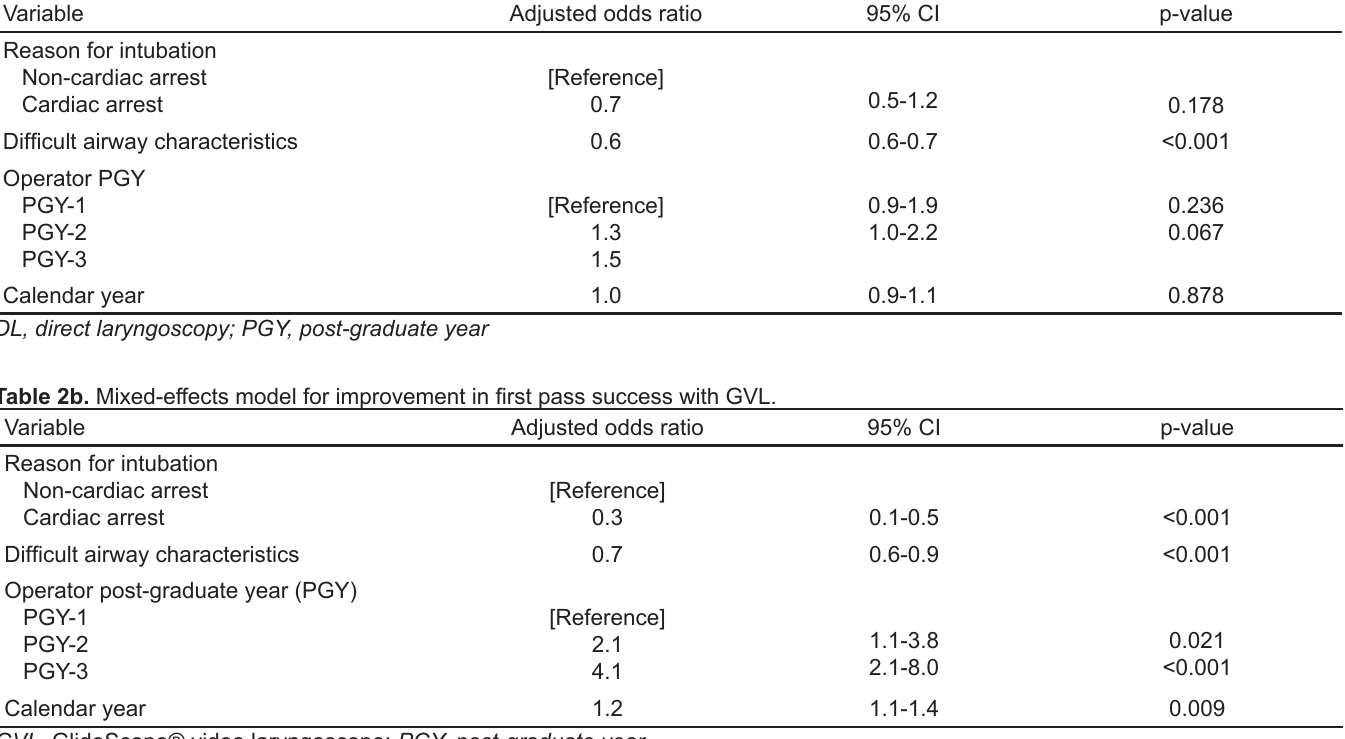
GVL, GlideScope® video laryngoscope; PGY, post-graduate